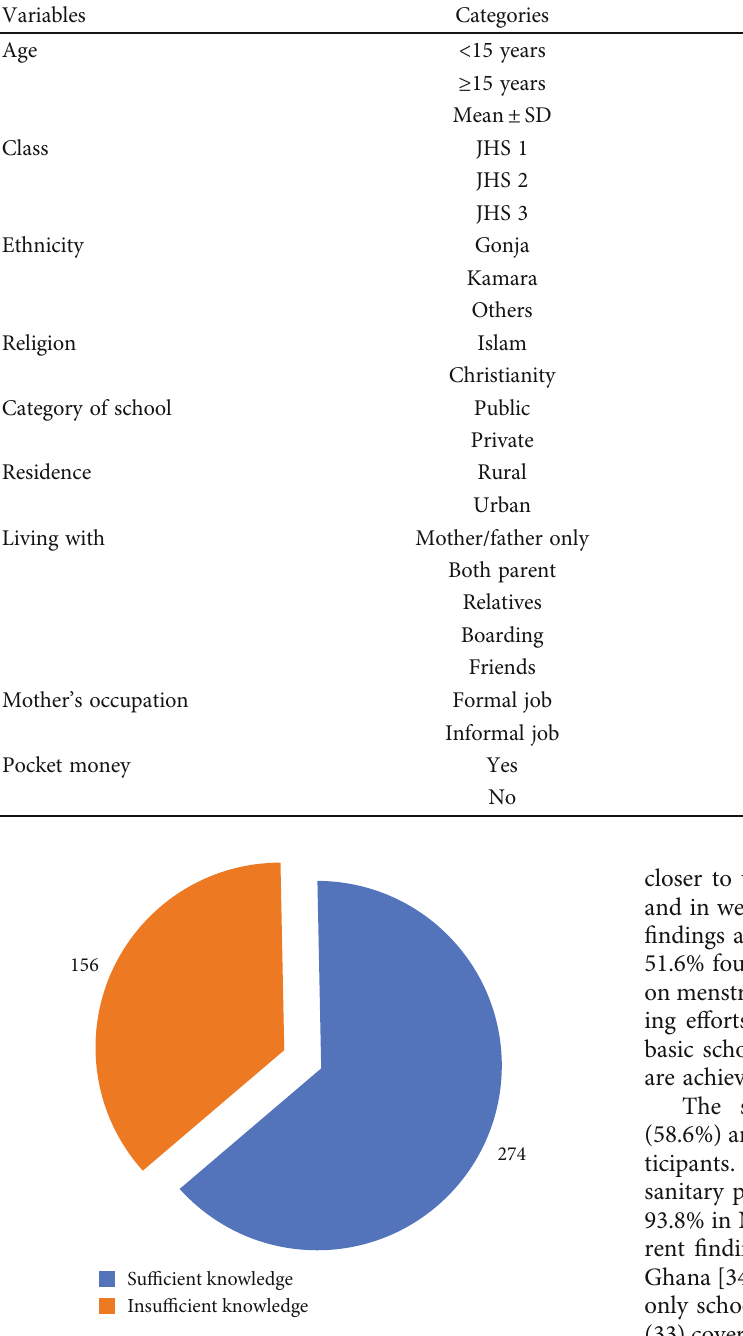
Figure 1: Overall knowledge of menstruation and menstrual